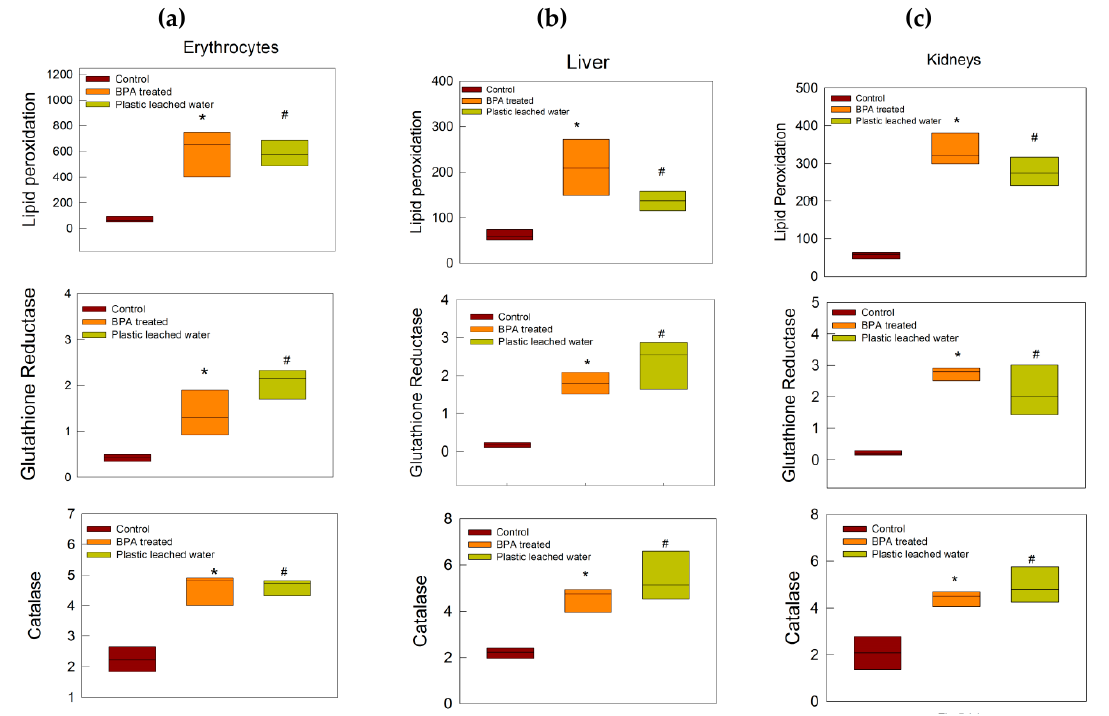
Figure 5. Oxidative stress-related enzyme activity in ( a ) erythrocytes, ( b ) liver, and ( c ) kidneys. Lipid peroxidation, glutathione reductase, and catalase activity increased in both the treated groups as compared to control rats. * and # indicate p < 0.05, Mann–Whitney U test.